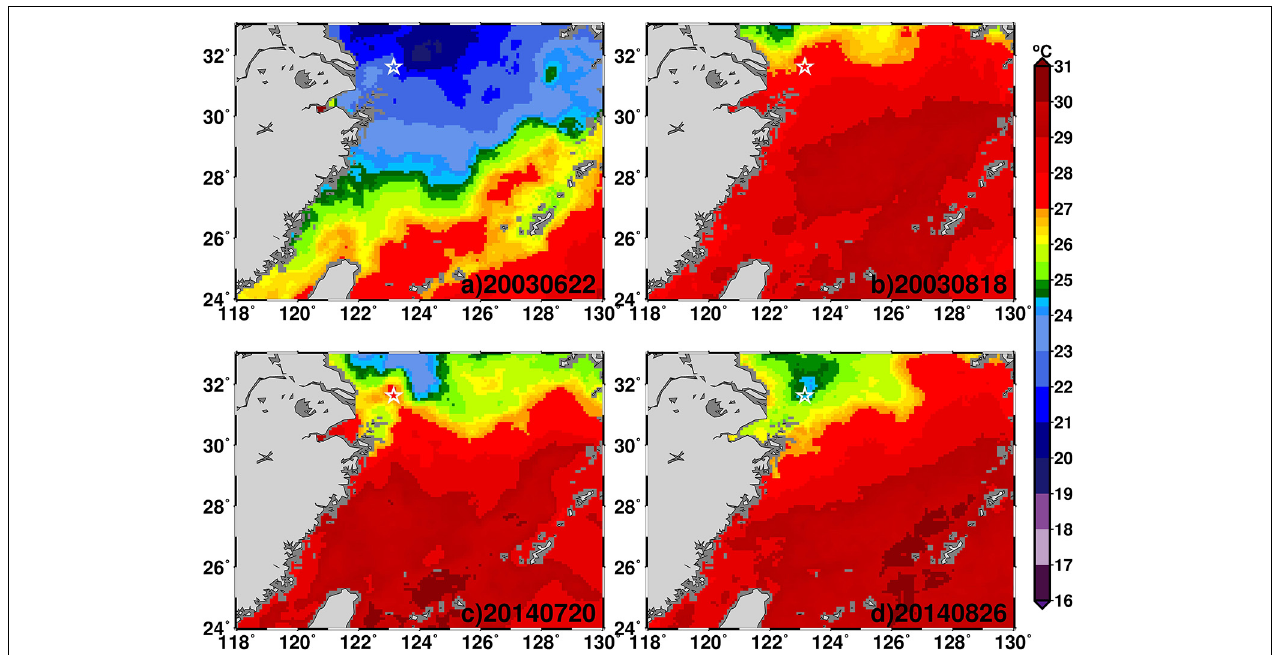
FIGURE 8 | Images of sea surface temperature (SST) of optimally interpolated satellite microwave and infrared (MW_IR OI SST) data on sampling date, displayed in labels, of St. 19 marked with (cid:73) in different sampling periods. Color code for SST is given for reference.